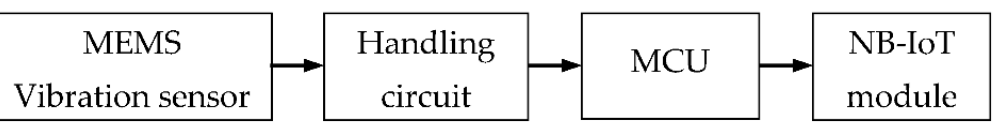
Figure 3. Block diagram of a wireless sensor circuit.